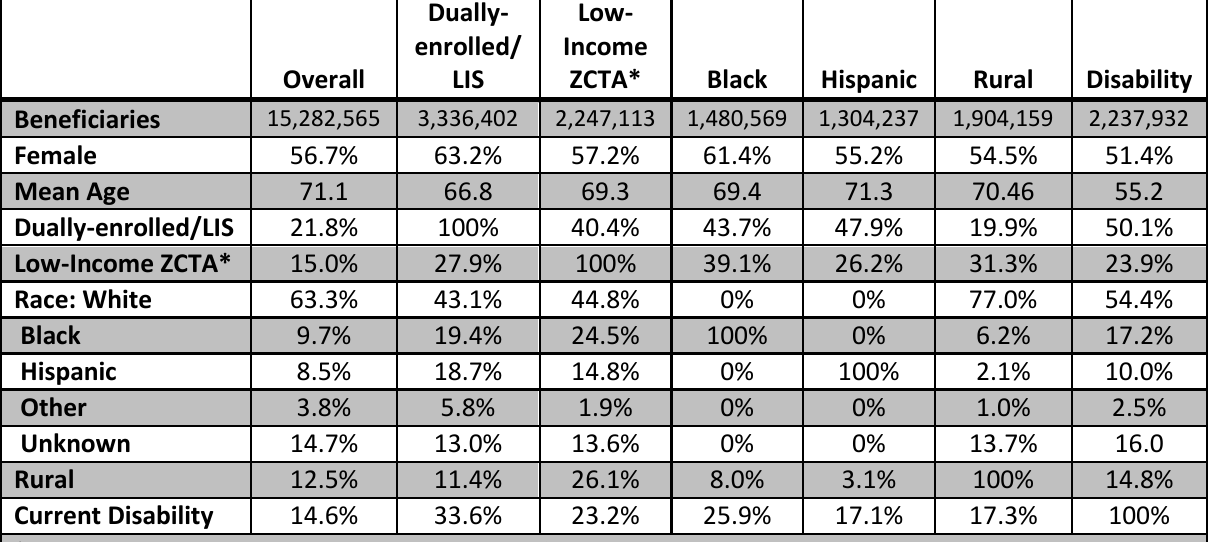
Table 8.1: Beneficiary Characteristics by Social Risk Category